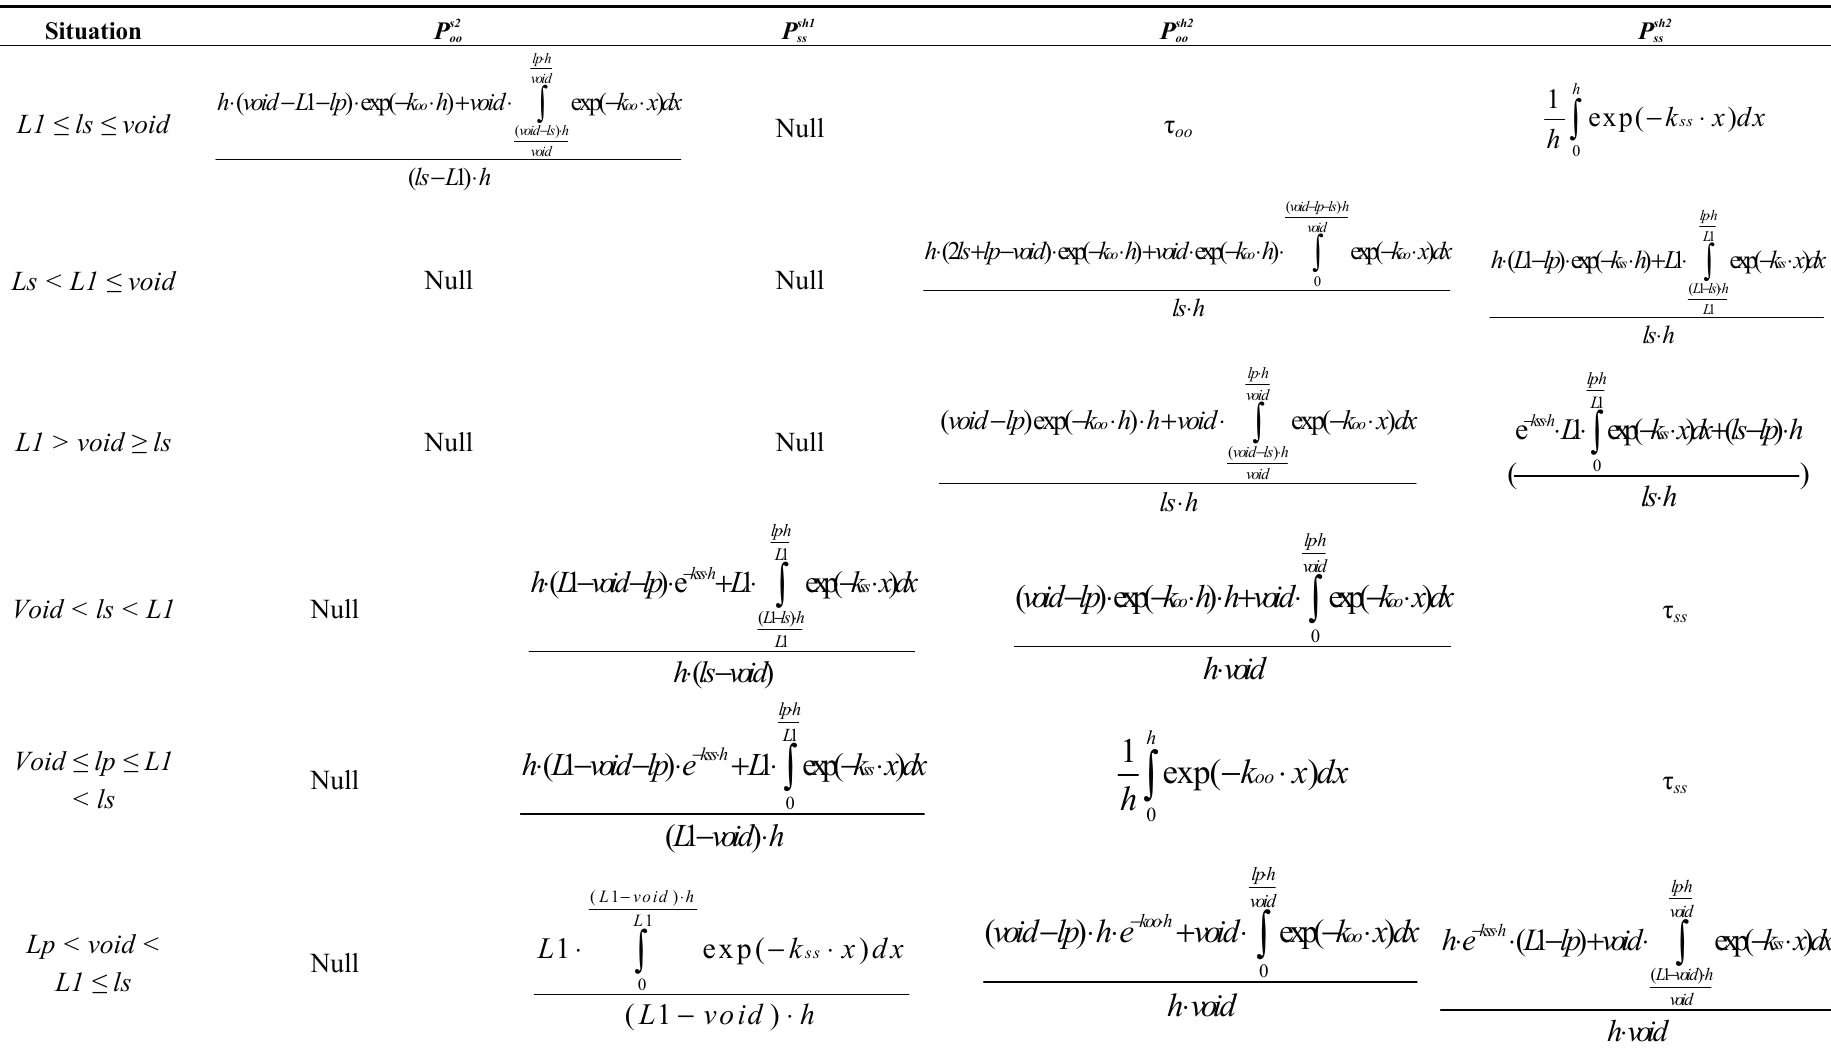
Table 2. The average gap probabilities of the direct light in the solar or viewing directions for different categories of background in different backward-scatter